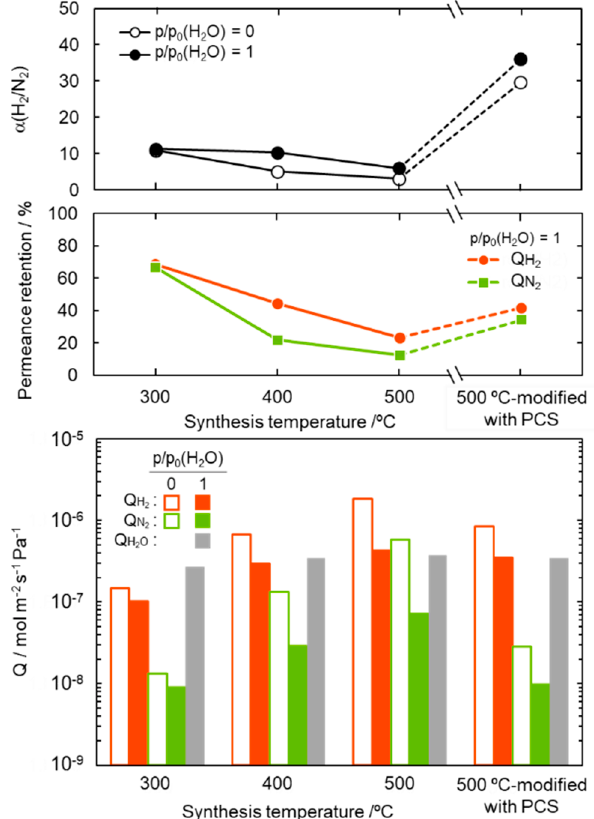
Figure 7. Gas permeation properties under the dry (p / p 0 (H 2 O) = 0) and wet (p / p 0 (H 2 O) = 1) condition at 50 ◦ C, and water vapor permeation properties at p / p 0 (H 2 O) = 1 at 50 ◦ C evaluated for SiCH hybrid / γ -Al 2 O 3 composite membranes synthesized at di ff erent temperatures of 300, 400 and 500 ◦ C, and the 500 ◦ C-synthesized membrane further modified with PCS by the melt impregnation at 120 ◦ C [50].